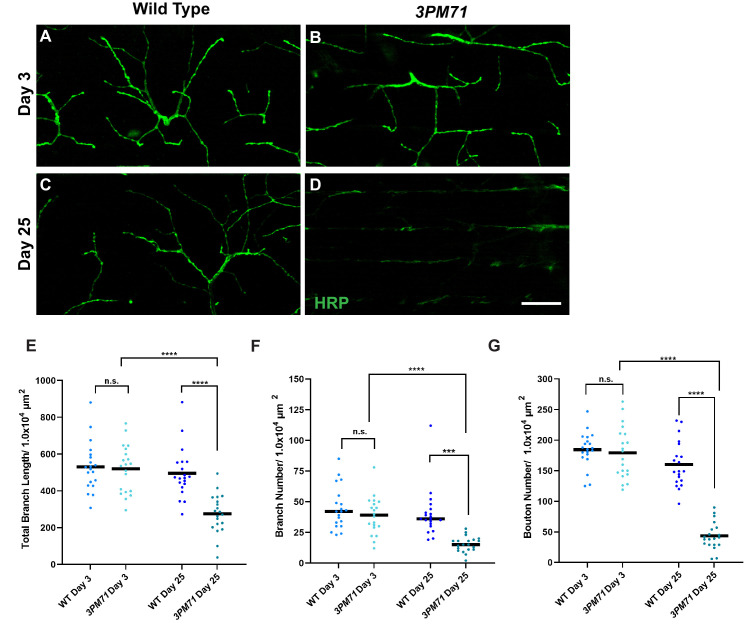
Progressive loss of NMJ integrity in 3PM71 mutants.(A–D) Confocal images of DLM NMJs labeled with FITC-conjugated HRP (green) at 63X magnification. (E–G) Quantification of (E) Total Branch Length, (F) Branch number, and (G) Bouton Number at both WT and 3PM71 NMJs. Sample size was n = 20 for each group. Black bars represent mean values. The mean total branch lengths for each data set from left to right as depicted in the graph (530.5 µM, 519.5 µM, 495.1 µM, and 274.9 µM). The mean branch number for each group as follows: 45, 39, 40, and 15. The mean bouton number (G) for each group as ordered in the panel, 185, 179, 161, and 43. ****, p-value<0.0001, *** p-value<0.001 using a Brown-Forsythe and Welch ANOVA tests with Post Hoc Dunnett’s multiple comparisons. N.S. = Not Significant. Scale bar in D represents 20 µM for all confocal images.
Figure 2—source data 1.Raw data for synaptic morphology.